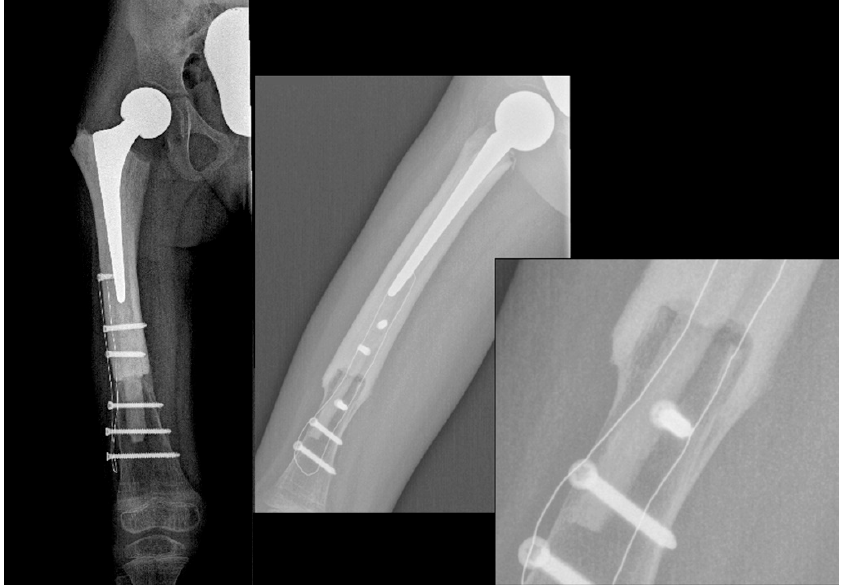
Figure 3. X ‐ ray showing a stable fusion between the allograft and the femur. Figure 3. X-ray showing a stable fusion between the allograft and the femur. The active hip range of motion (ROM) was flexion 80 ◦ , extension 10 ◦ , abduction 20 ◦ . The active knee joint ROM was: flexion 110 ◦ and extension 0 ◦